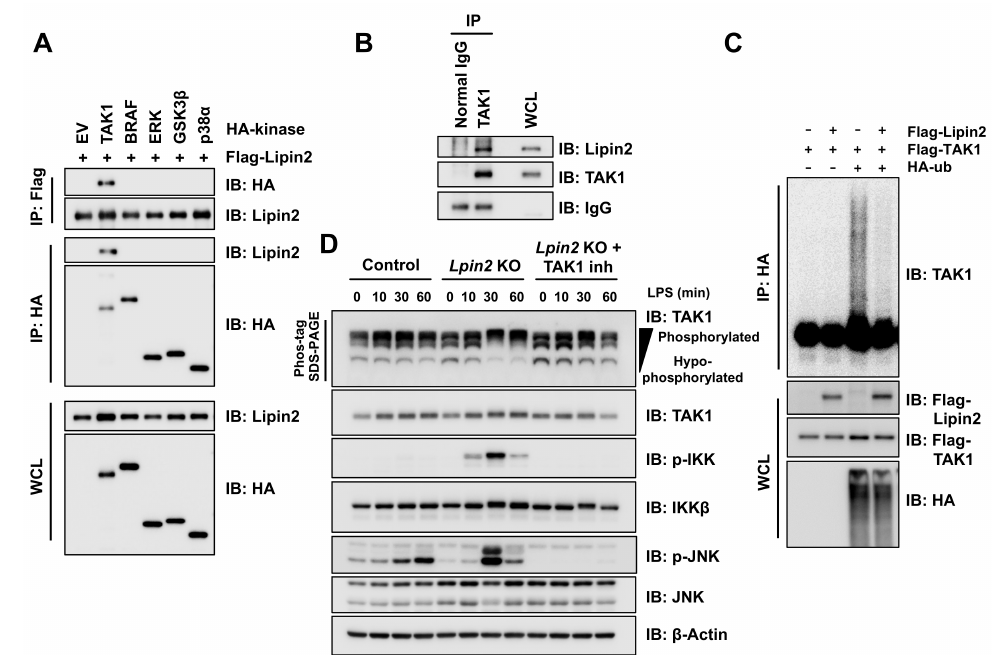
Figure 4. Elevated TAK1 activity induces downstream pathways in Lpin2 knockout RAW-D cells. ( A ) IB analysis of WCLs and anti-Flag/anti-HA IPs derived from 293T cells transfected with the indicated expression plasmids. At 48 h after transfection, the cells were harvested for IP. ( B ) IB analysis of WCLs and anti-TAK1 IPs derived from RAW-D cells. Normal mouse IgG was used as control IP. ( C ) In-cell TAK1 ubiquitination assay. IB analysis of WCLs and anti-HA IPs derived from 293T cells transfected with the indicated expression plasmids. At 36 h after transfection, the cells were pretreated with 15 µ M MG132 proteasome inhibitor for 12 h before harvesting. ( D ) IB analysis of WCLs derived from control (WT) and Lpin2 KO RAW-D cells treated with 200 ng/mL LPS. Cells were pretreated with DMSO or 1 µ M 5Z-7-oxozeaenol TAK1 inhibitor as indicated for 1 h before LPS treatment. The cells were harvested for IB analysis at the indicated time points. For enhanced electrophoretic separation of phosphorylated TAK1 species, the WCLs were resolved by Phos-tag SDS-PAGE as